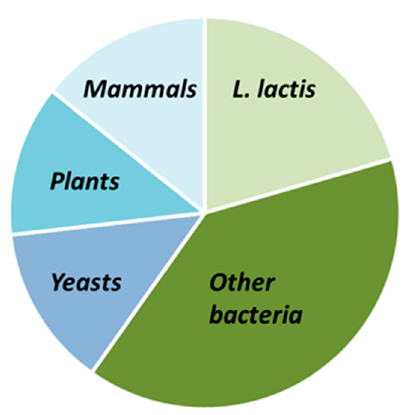
Figure 2. Comparison of MPs expressed in L. lactis using the NICE system depending on their origin: L. lactis , other bacteria, or eukaryotic cells.